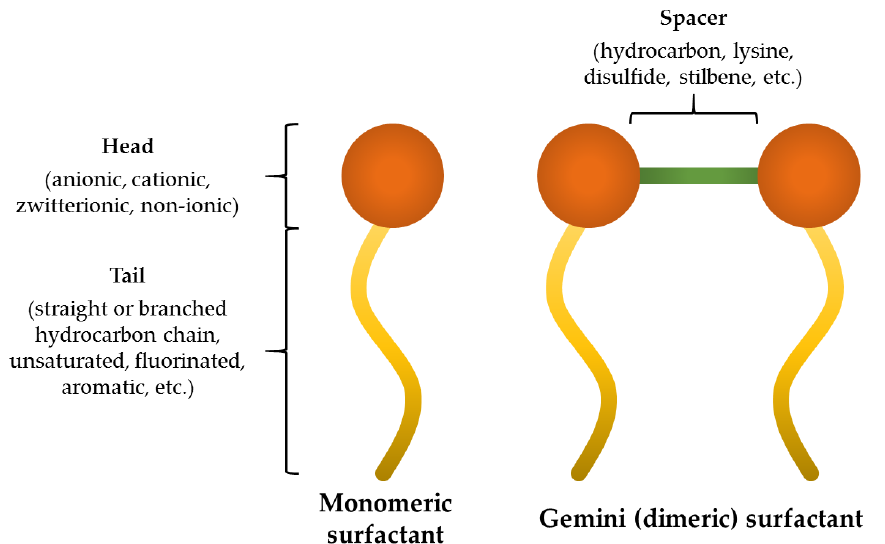
Figure 2. General structure of monomeric and dimeric (gemini) surfactants.